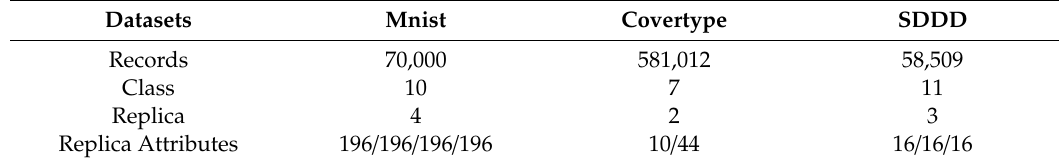
Table 1. Description of datasets.